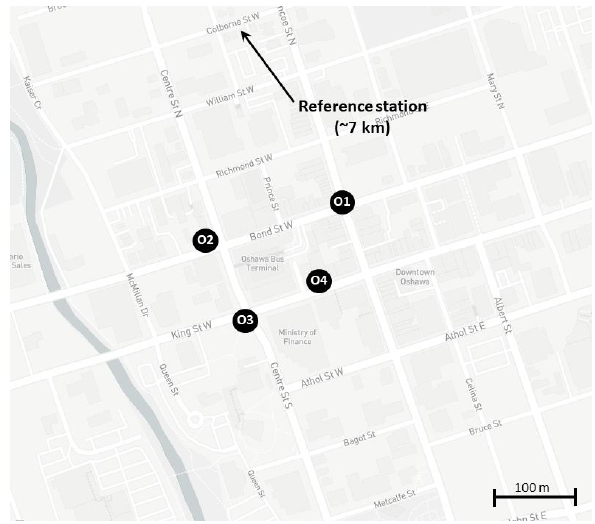
Figure 2. Locations of AirSENCE™ devices S1–S6 in the GTA Satellite Smart City, Ontario.